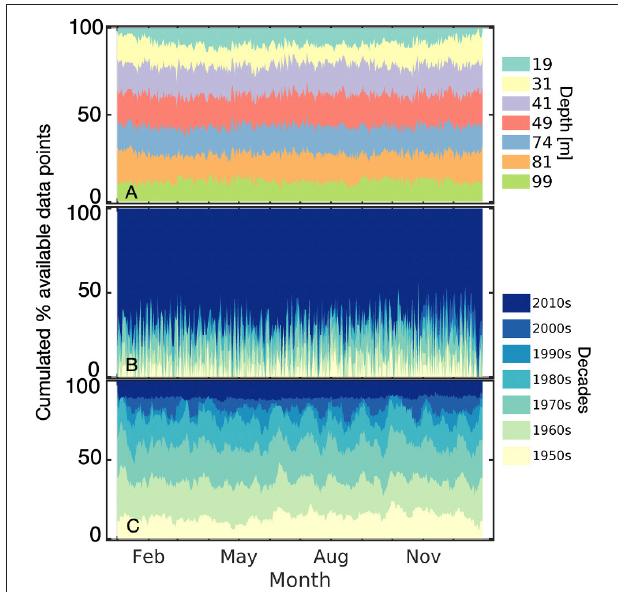
FIGURE 6 | The cumulated percentage of (A) available data points used at each depth bin, (B) available data points for each decade, and (C) available data points for each decade when incorporating a ± 2day time-centered window and a bottle to mooring (b:m) ratio of 6:1. Each panel shows the cumulated percentage for each climatology